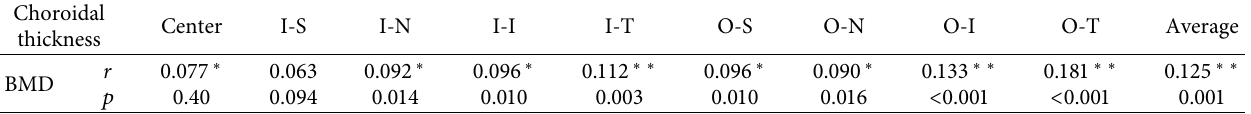
Table 3: Correlation analysis results between choroidal thickness and BMD.